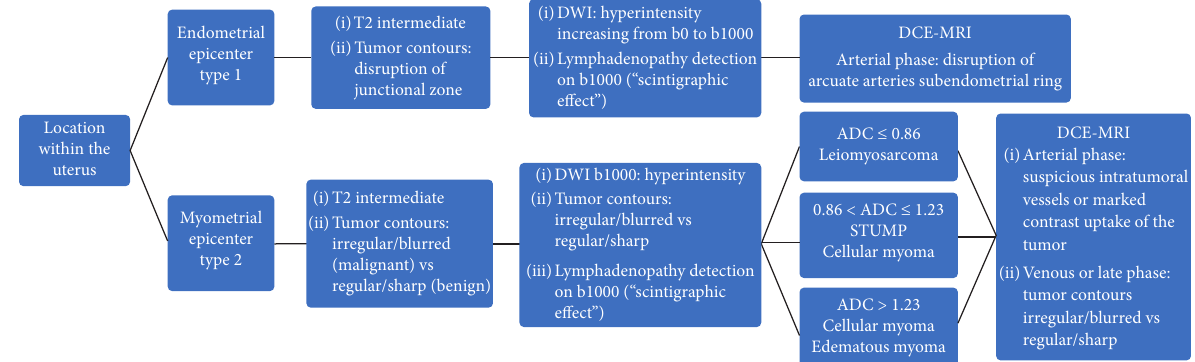
Figure 10: Diagnostic algorithm to assess malignant MR features and to suggest pathological hypotheses. For type 2 tumors, the radiologist needs ADC values only if the lesion has a high b1000-weighted